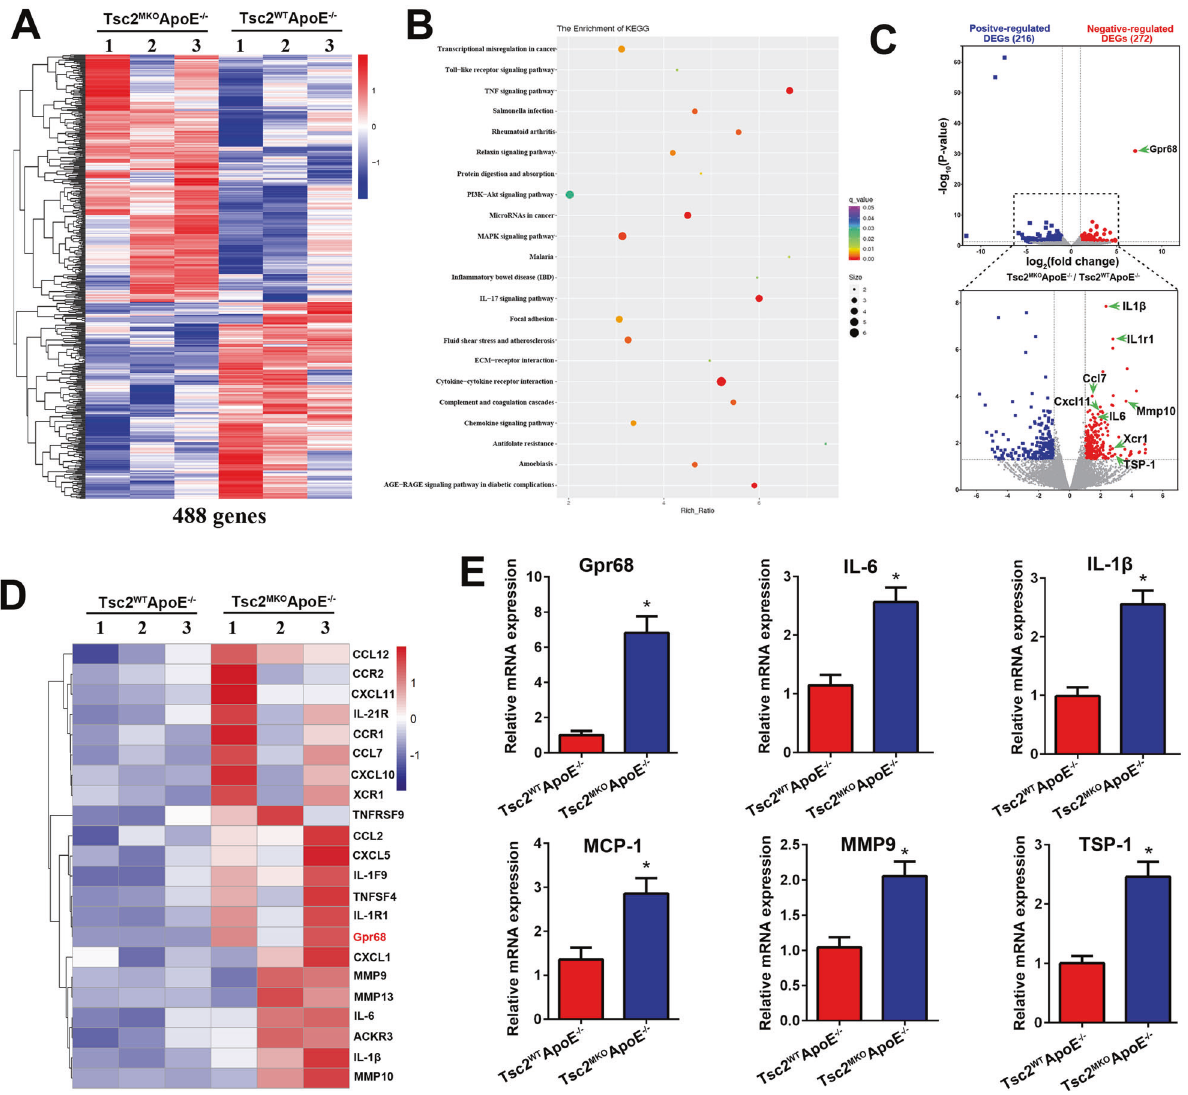
Fig. 4 Identi fi cation of target genes regulated by Tsc2 with genome-wide RNA-seq analysis. A Heat map displayed the top genes with altered expression (|log2FC | >1) in the peritoneal macrophages from Tsc2 MKO ApoE – / – mice versus Tsc2 WT ApoE – / – infused with AngII for 7 d. B KEGG pathway enrichment analysis was conducted. C Valconoplot shows genes whose expression was signi fi cantly altered upon Tsc2 deletion. Blue plots represented signi fi cant positive-regulated genes and the red plots for negative-regulated genes. D Heat map of the selected genes from ( A ). E Quantitative real-time PCR were performed to evaluate mRNA expression of the indicated genes ( n = 5). * P < 0.05, vs. macrophages from Tsc2 WT ApoE – / – mice infused with